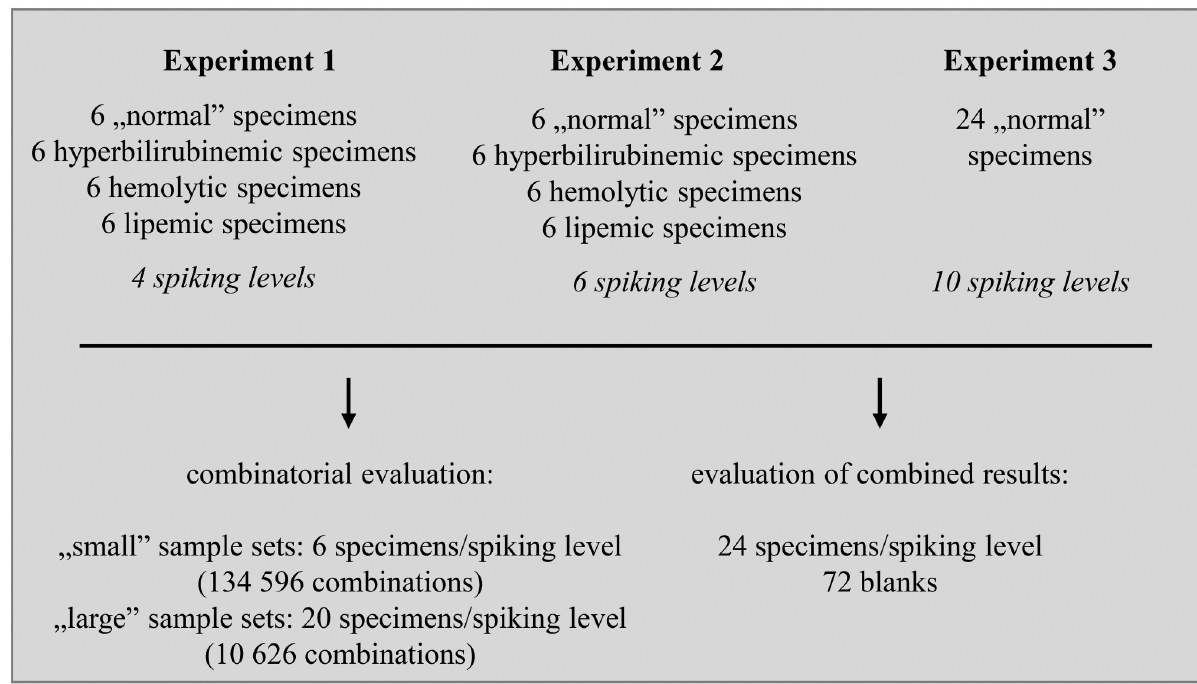
Fig 2. Presentation of the experimental design. 3 experiments were performed. The impact of sample size, the number of spiking levels and common interferences was assessed on “small” and”large” sample sets containing 6 and 20 samples, respectively, using a combinatorial approach. The final assay error equations were established by using all of the results obtained in the 3 experiments (N = 24 specimens/spiking level, M = 20 spiking levels+blank).